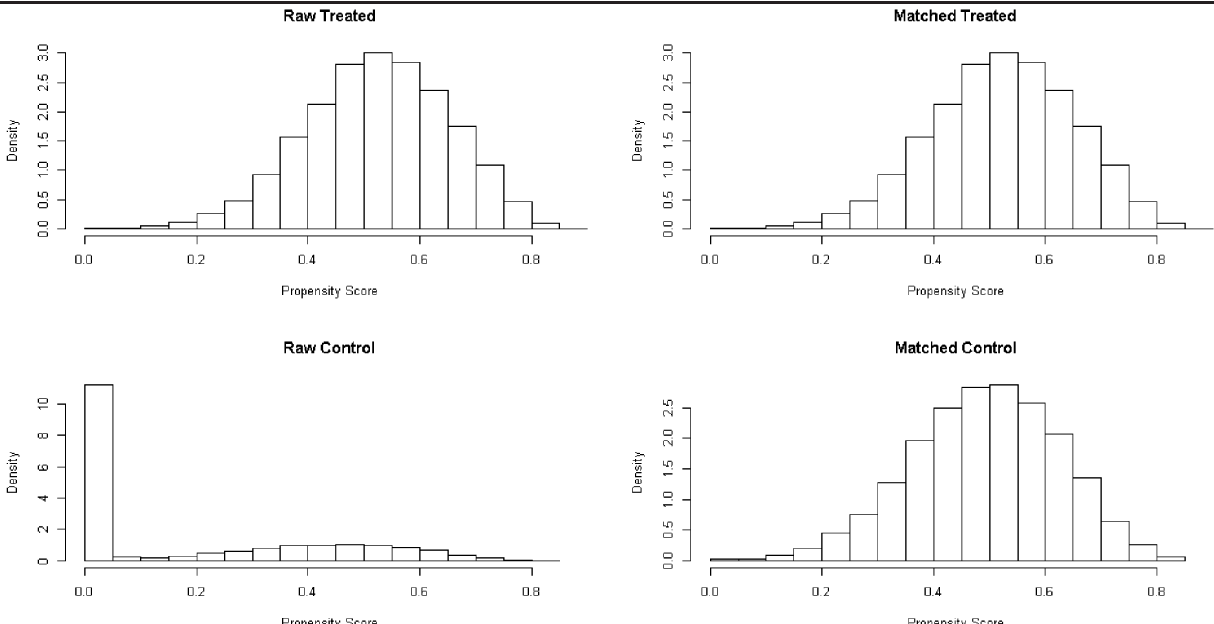
Table 2. Standard errors clustered at the individual level are in the parenthesis.